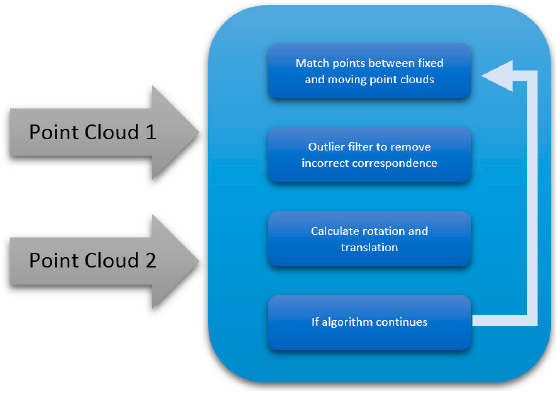
Figure 1. Point cloud rigid registration algorithm [28].